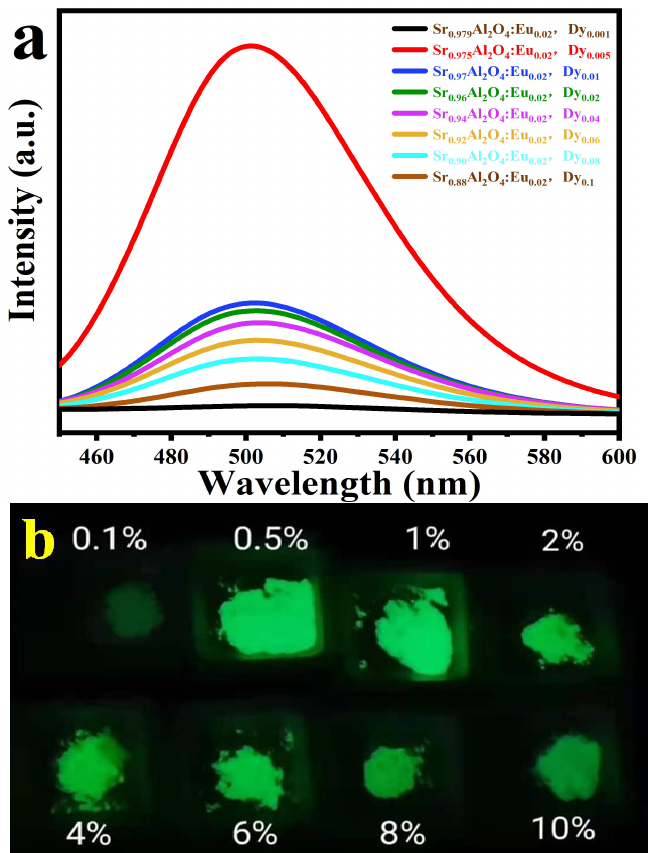
Figure 5. ( a ) emission spectra of different Dy 3+ doping amounts ( λ em = 365 nm); ( b ) Luminescence of different Dy 3+ doping amounts under 365 nm UV lamp